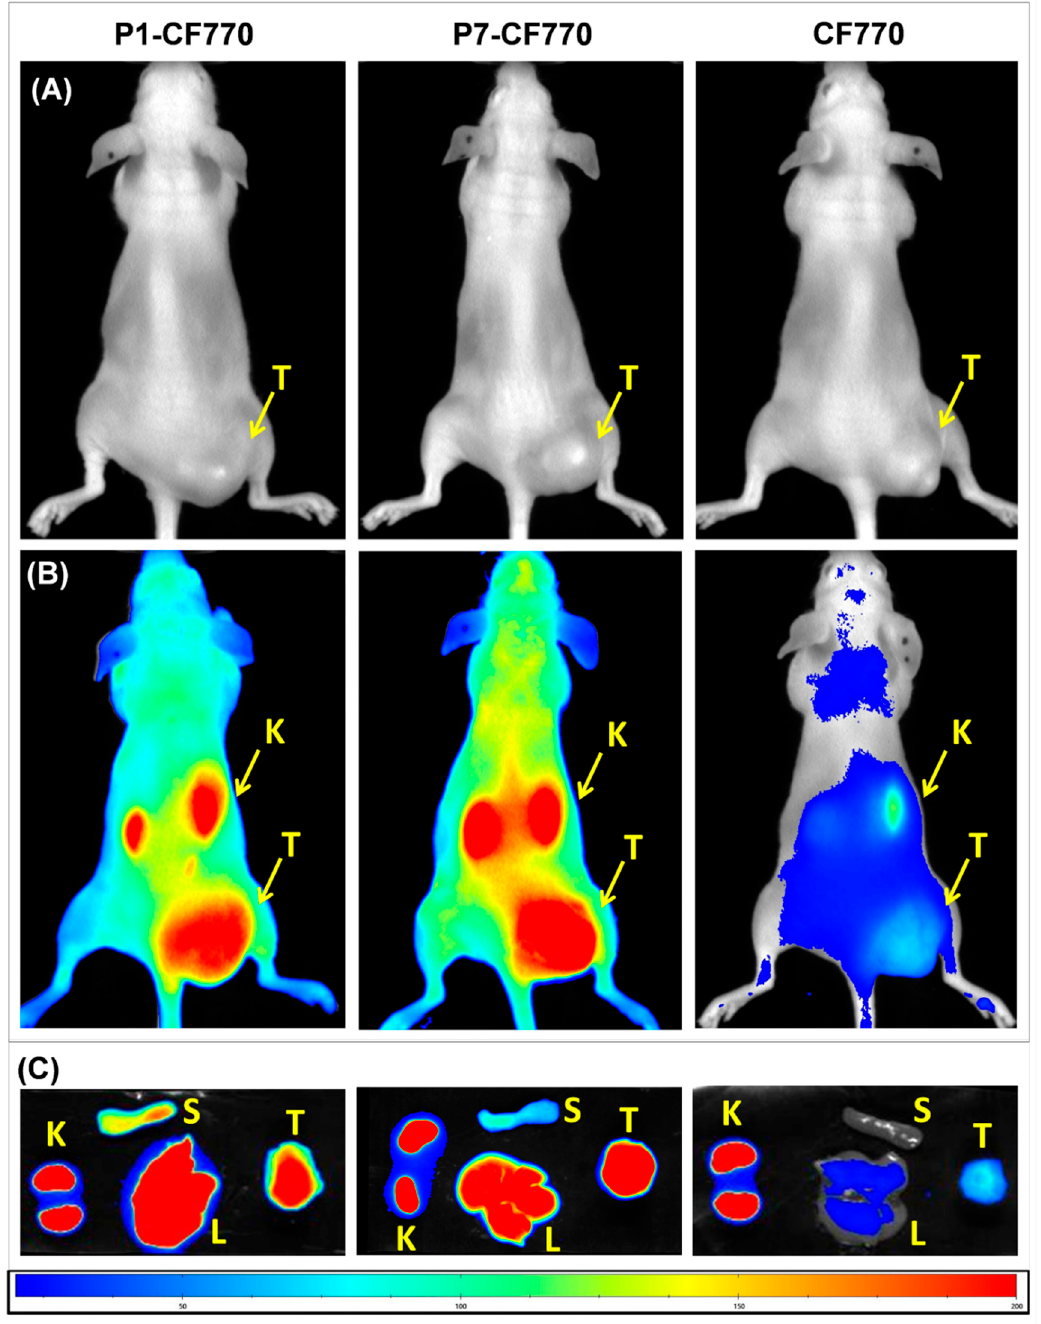
Figure 8. Images acquired by fluorescence lifetime imaging (FLI) of TPC-1 tumors grafted in athymic nude mice before ( A ) and after the injection of P1-CF770, P7-CF770, or CF770 ( B ). Ex vivo FLI images of TPC-1 tumors ( T ), liver ( L ), spleen ( S ), and kidneys ( K ) are shown in ( C ).